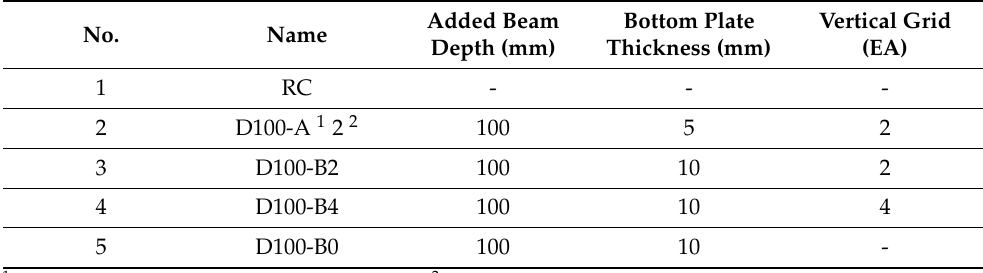
Table 3. The test specimen parameters.